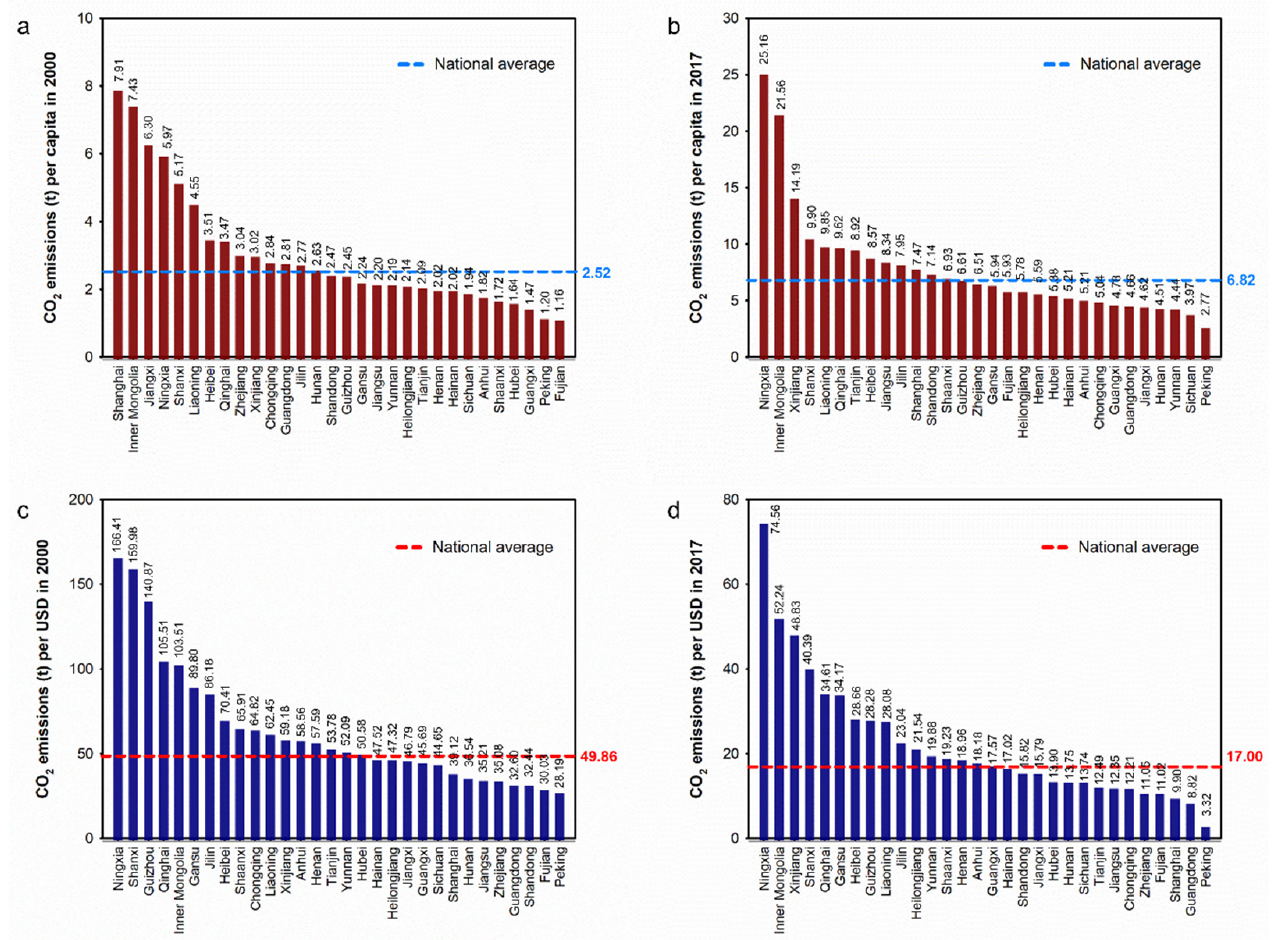
Figure 8. CO 2 emissions per capita (t) in ( a ) 2000 and ( b ) 2017 in each provincial administrative unit. CO 2 emissions per USD (g) in ( c ) 2000 and ( d ) 2017. The dotted line indicates the national average.